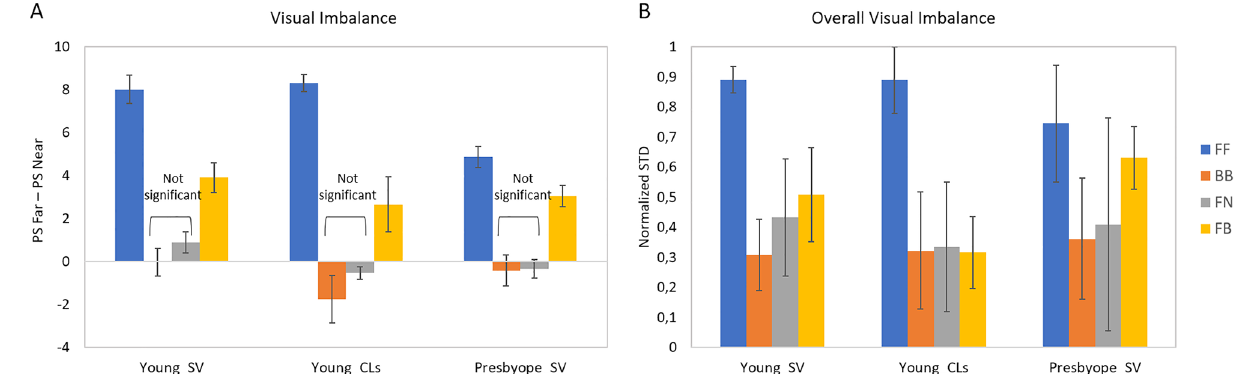
Figure 7. ( A ) Visual imbalance between distances (difference PS Far-PS Near) for each correction and group (averaged across light conditions and subjects). ( B ) Overall visual imbalance (normalized standard deviation in PS, averaged across subjects) for each for each correction and